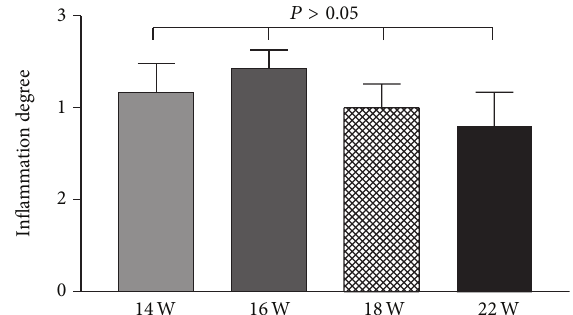
Figure 3: Graph analysis of bowel inflammation degree changes along the neoplastic transformation in ICR mice dosed with DMH and DSS over examined time-points. The administration of DMH and DSS for 14 weeks evoked a strong inflammation in the colorectal mucosa through 16 and 18 weeks and persisted to 22 weeks ( 𝑃 value was obtained with the Mann-Whitney U